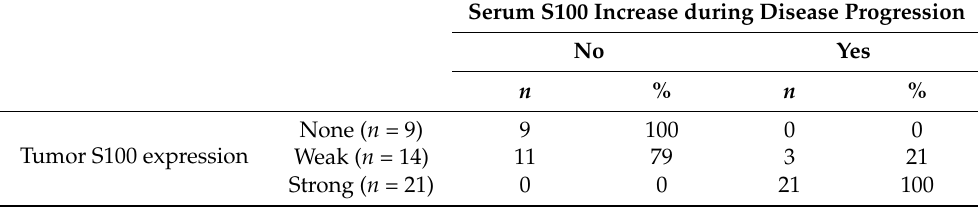
Table 3. Dependence of serum S100 increase on tumor S100 expression. The difference between the groups was statistically significant ( p <